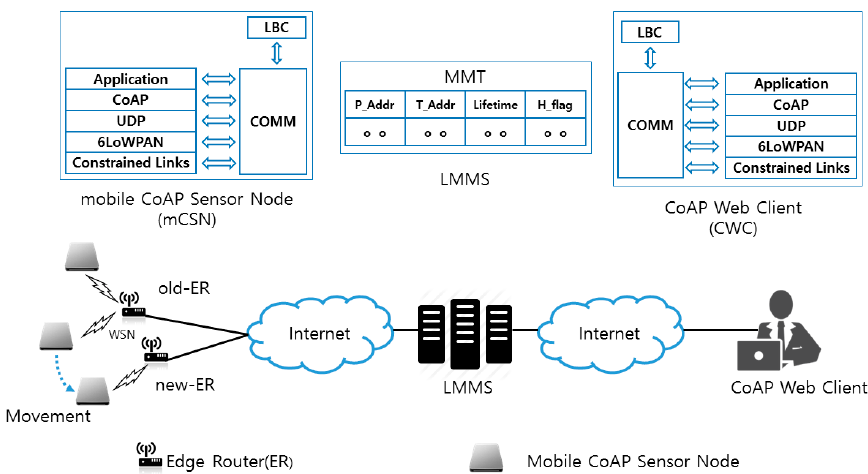
Figure 1. Reliable mobility management architecture using Constrained Application Protocol (CoAP)-based Mobility Management Protocol CoMP.